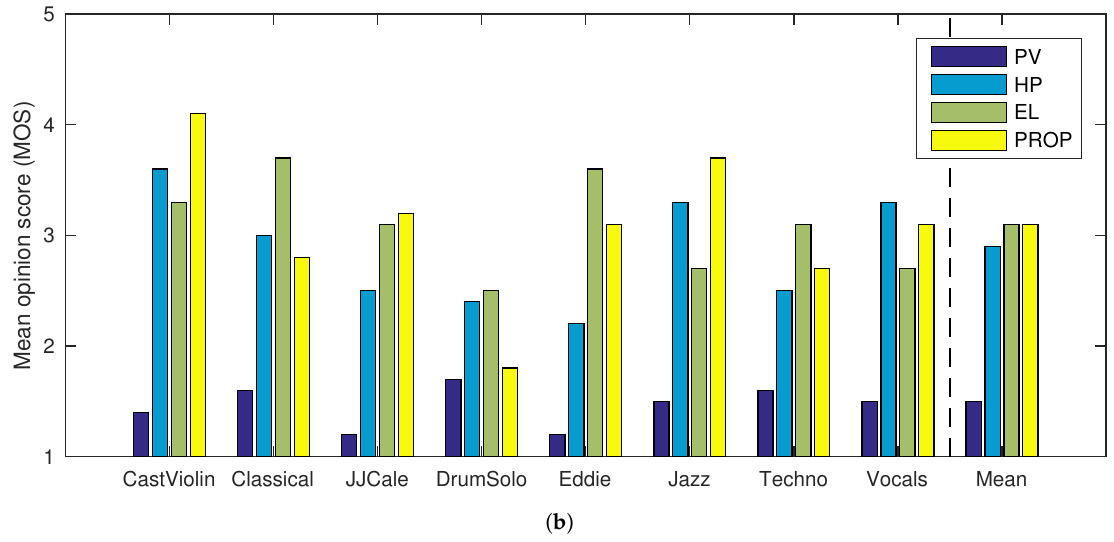
Figure 8. Mean opinion scores for eight audio samples using four TSM methods for ( a ) medium ( α = 1.5), and ( b ) large ( α = 2.0) TSM factors. The rightmost bars show the average score for all eight samples. PV: phase vocoder; HP: harmonic–percussive separation [28]; EL: élastique [36]; PROP: proposed